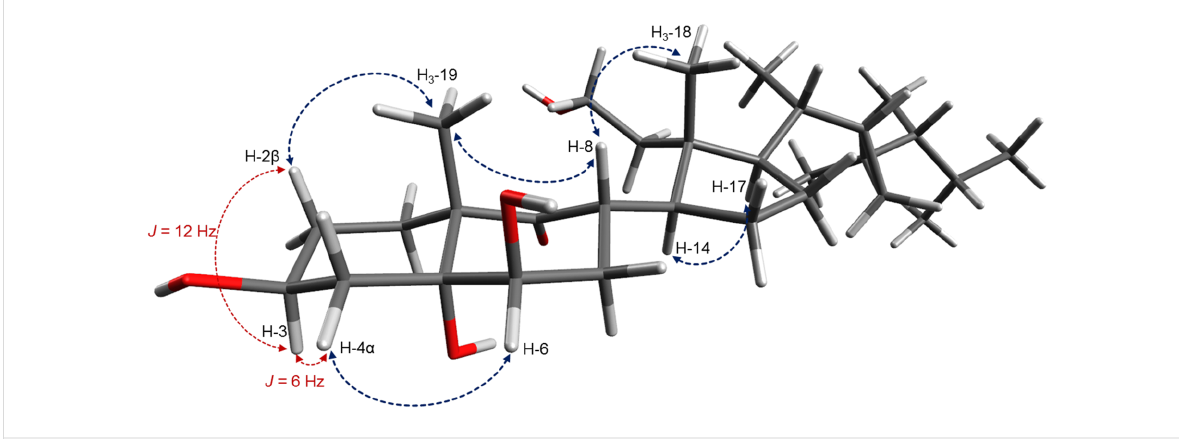
Figure 5: Conformational structure of 1 (key NOESY correlations are indicated with blue arrows; coupling constants crucial for the determination of the orientation of the 3-OH group are shown).